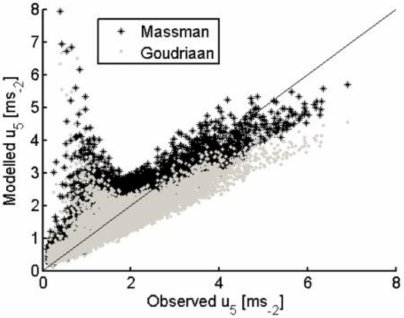
Figure 7. Wind-speed estimated and measured at 5 m over Las Majadas using the modified wind profile (Equations